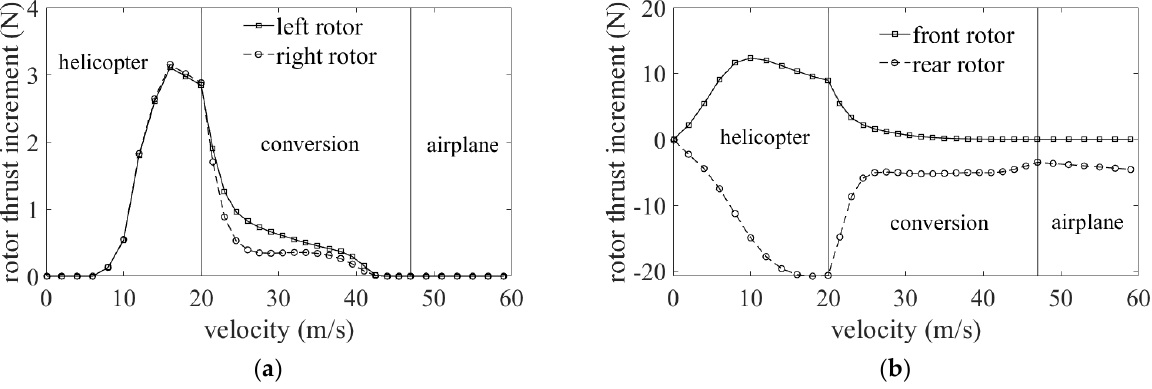
Figure 13. Influence on rotor thrust with different rotor – rotor interaction. ( a ) Rotor thrust increment caused by lateral interaction. ( b ) Rotor thrust increment caused by longitudinal interaction.